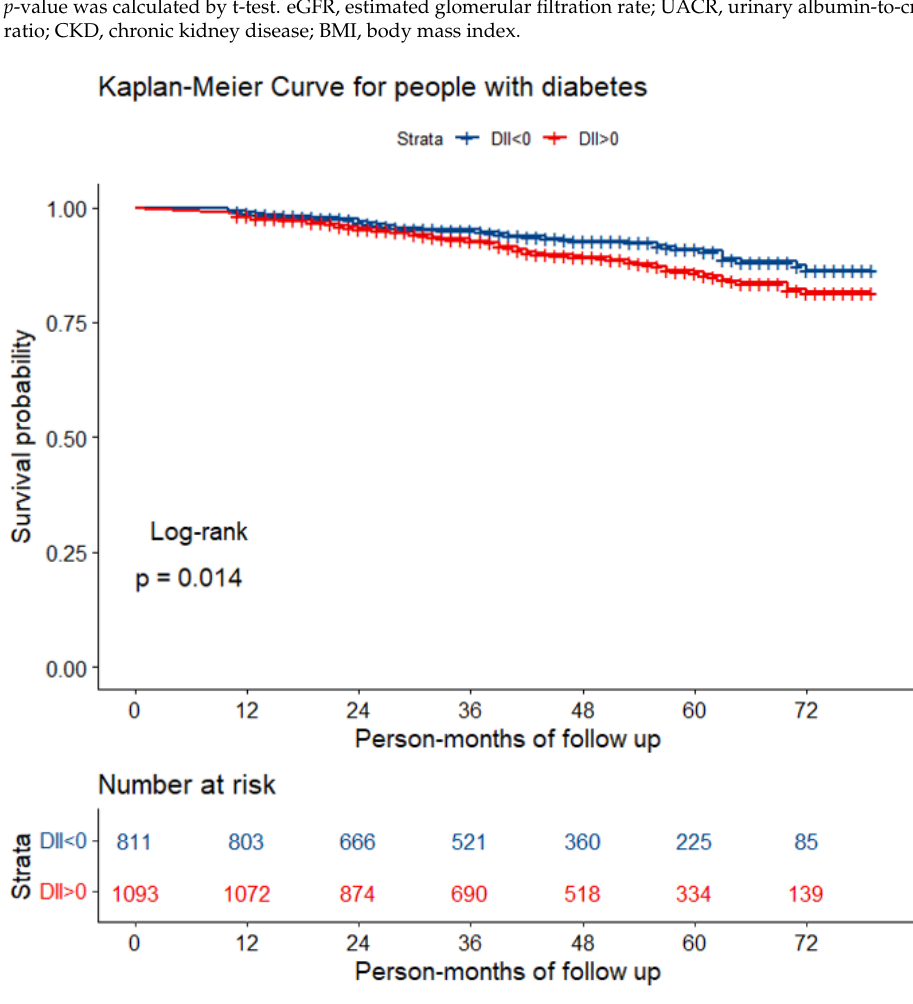
Figure 2. The Kaplan–Meier curve for diabetic patients with different diets.